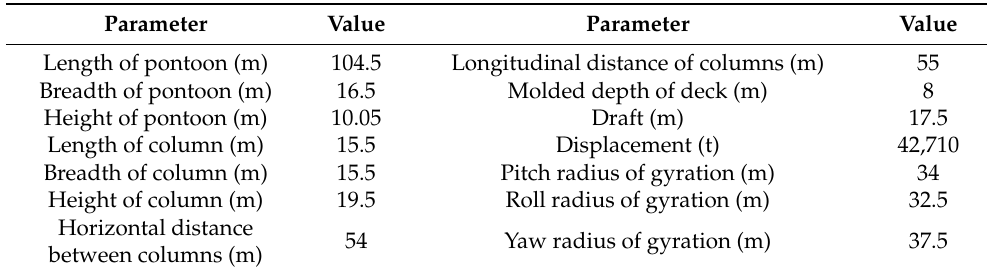
Table 2. Main characteristic of